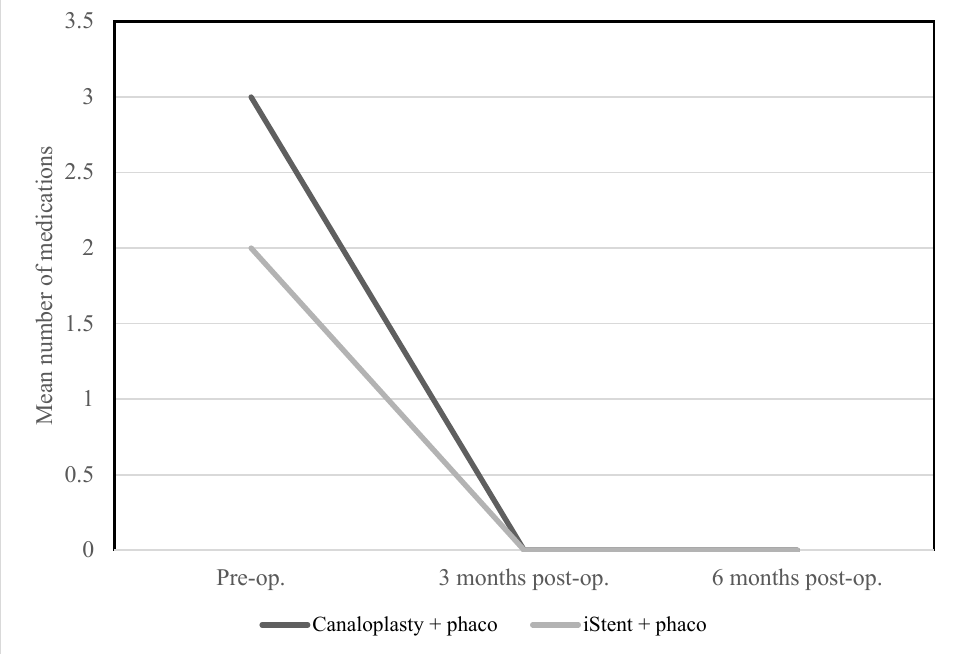
Figure 1. Mean IOP from baseline to 6 months post-surgery according to type of surgery (PC vs. PiS).